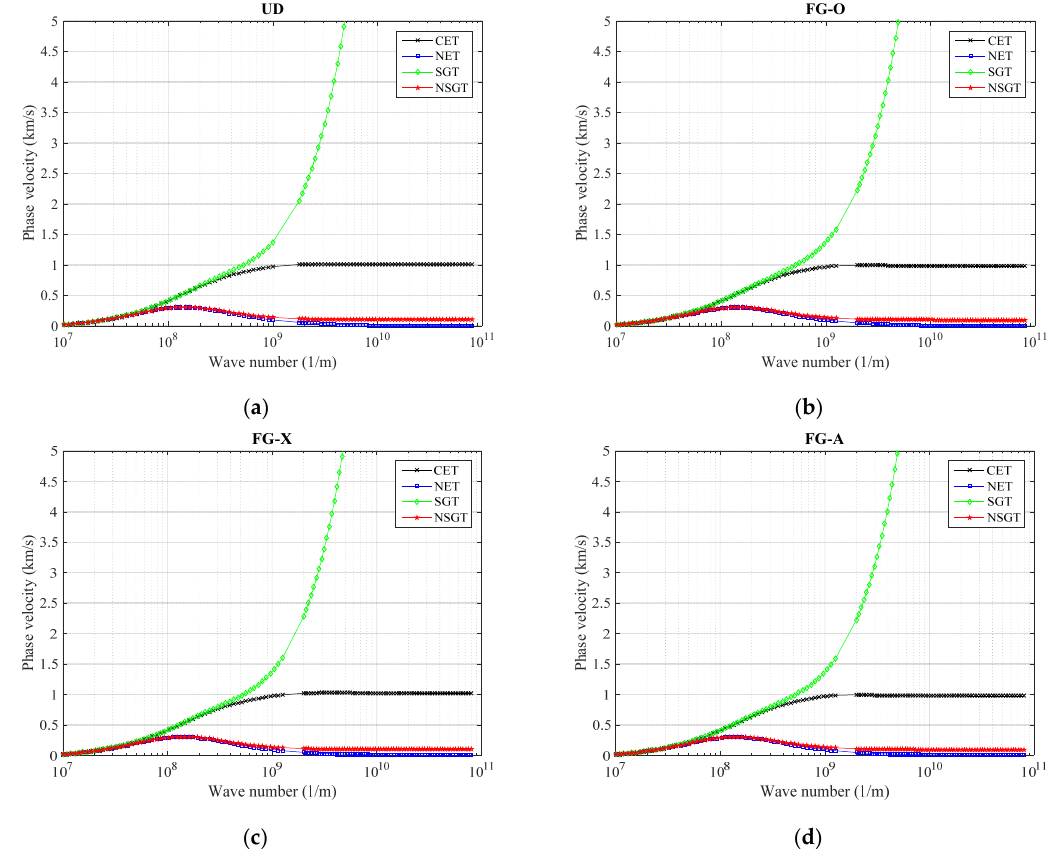
Figure 6. The variation of phase velocity versus different size-dependent theories for ( a ) UD, ( b ) FG-O, ( c ) FG-X, and ( d ) FG-A patterns of GNPs ( α = π /4, ℓ = 1 nm, μ = 10 nm, g * GNP = 1%, N l = 10).